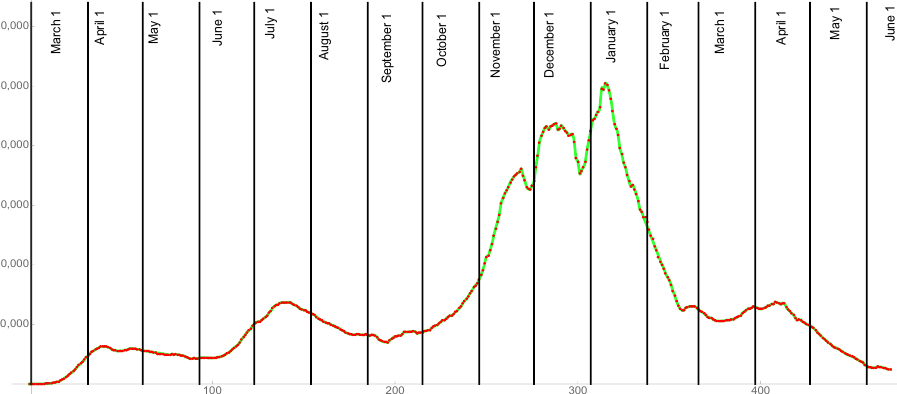
Figure 2. Red dots are discrete rolling weekly averaged daily reported cases from 1 March 2020 to 15 June 2021, and the green graph is the continuum cubic spline interpolation CS ( t ) of the red dots. Let dr ( t 1 ) , dr ( t 2 ) , . . . be the rolling weekly average number of daily reported cases each day, from the first week of March, 2020 up to the last day of daily reported cases 15 June 2021, where time t 1 , t 2 , . . . is discrete, day by day. In the model, the continuum version DR ( t ) of dr ( t 1 ) , dr ( t 2 ) , . . . , can be assumed to satisfy